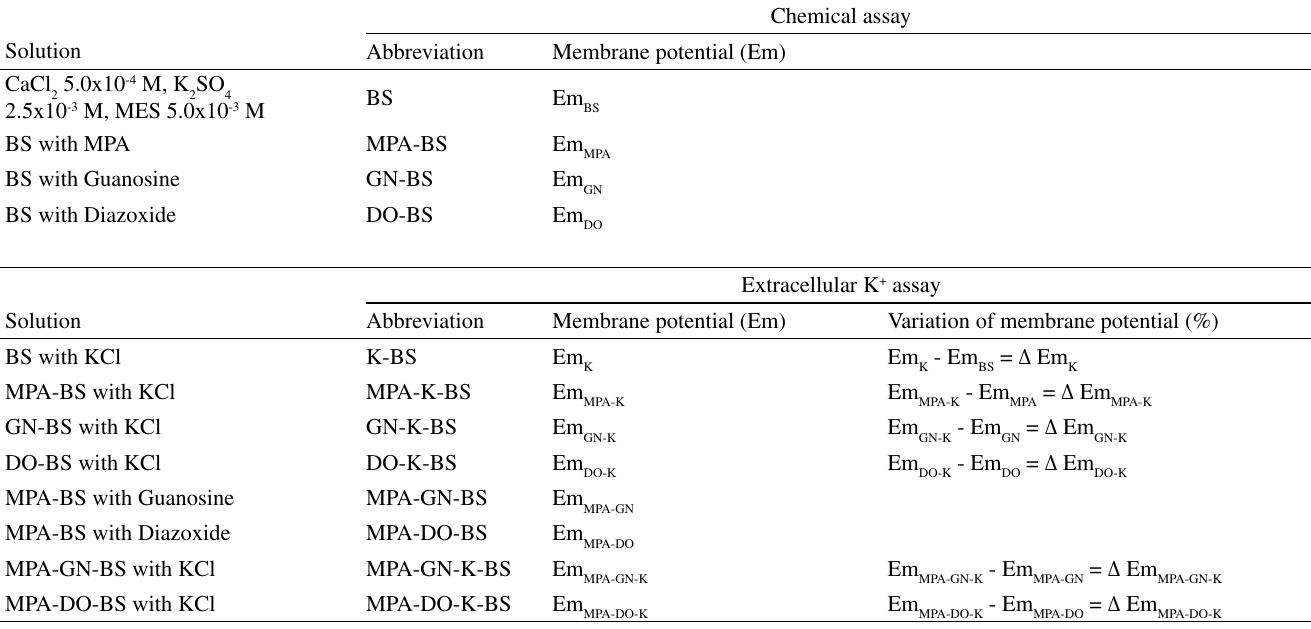
Table 1 - Solutions used in membrane potential